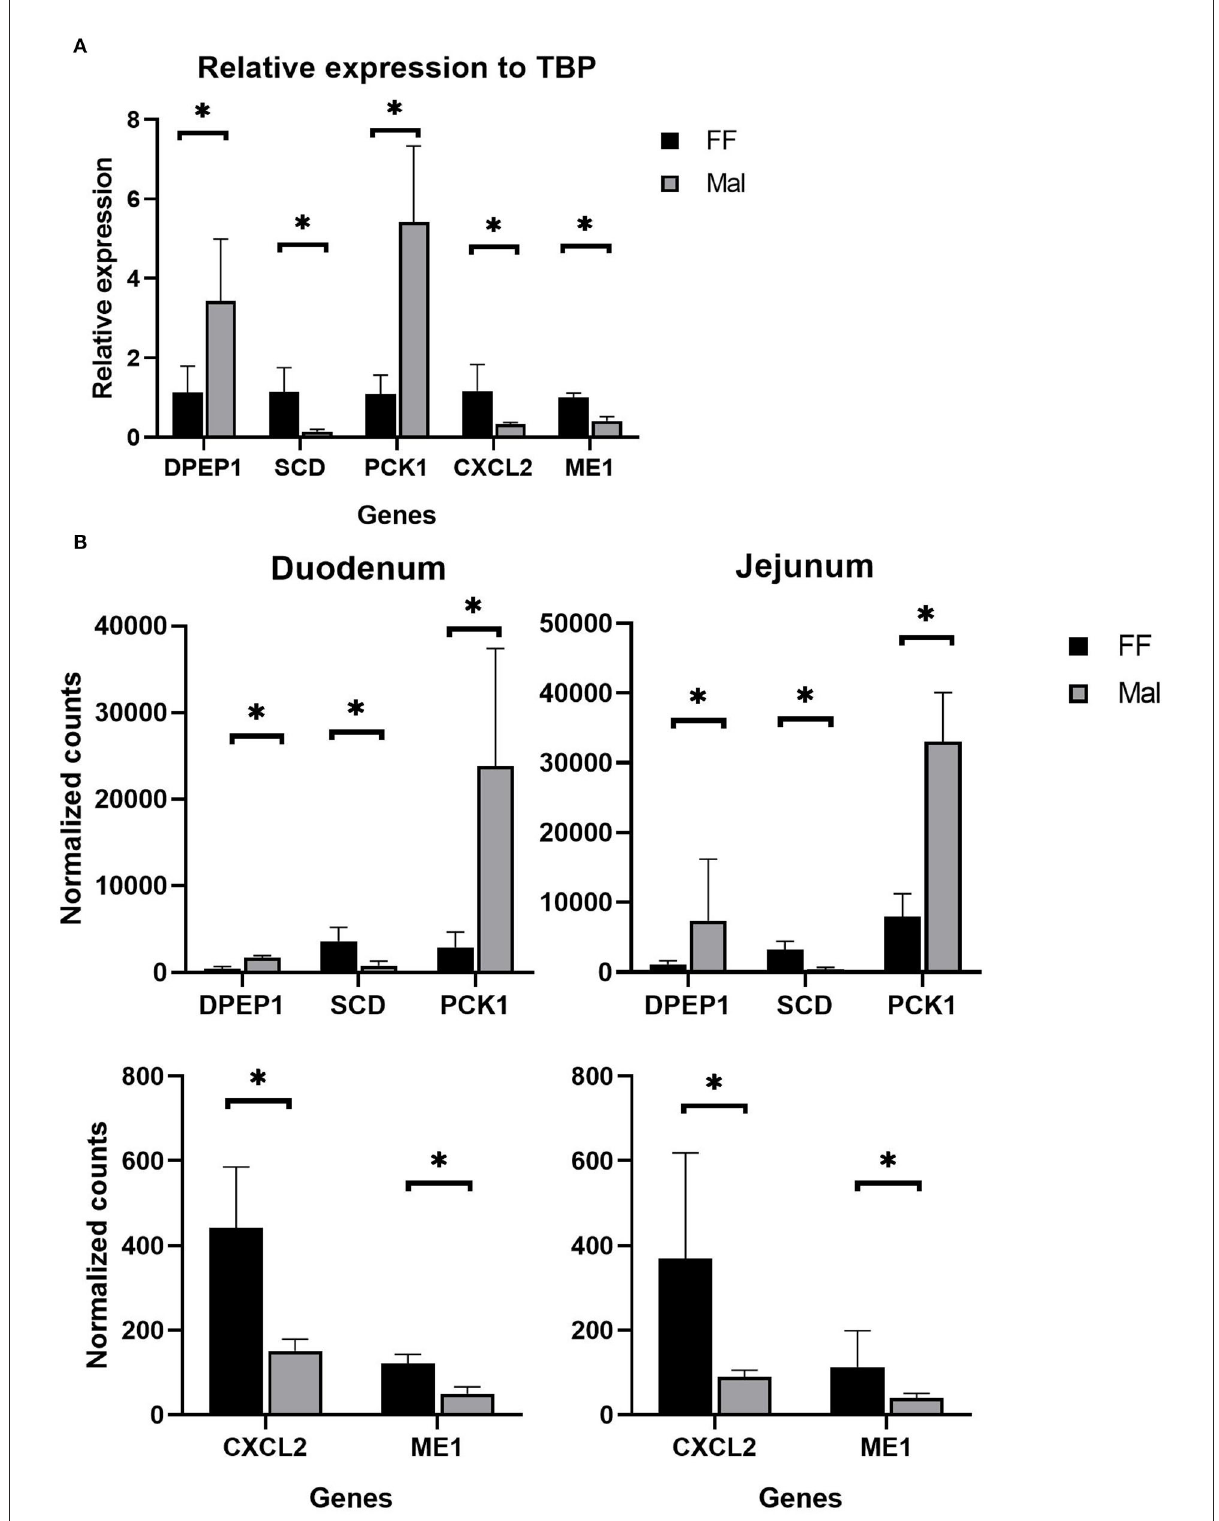
FIGURE5 Validation of RNAseq data. (A) qPCR results of relative expression normalized to TATA box binding protein using jejunum (DPEP1, SCD, and PCK1) and duodenal samples (CXCL2 and ME1). *Significantly different ( p < 0.05) by the Wilcoxon test. (B) Normalized counts from Salmon of animals from the full-fed (FF, n = 4) and malnourished (Mal, n = 4) groups in the duodenum and jejunum. *Significantly different ( p <